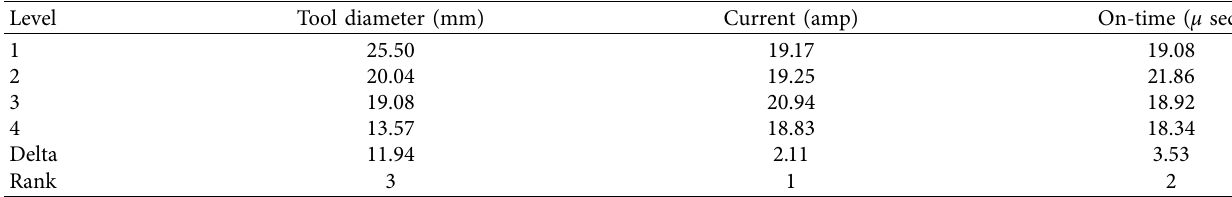
Table 7: Means response for the Taguchi method.